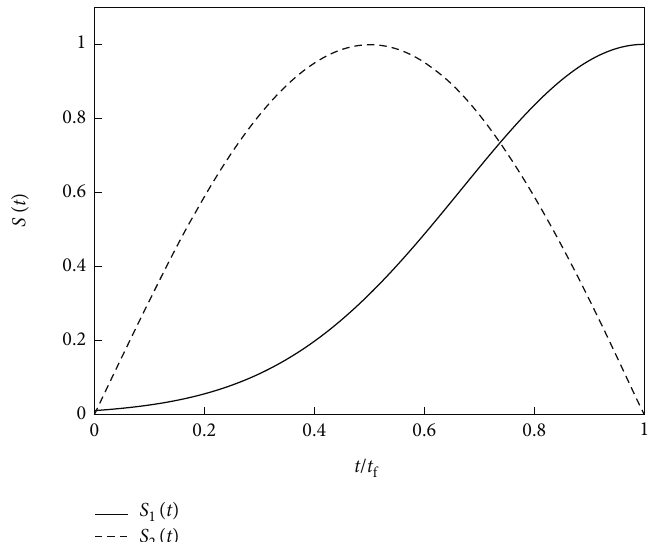
ð t Þ and S ð t Þ . 1 2